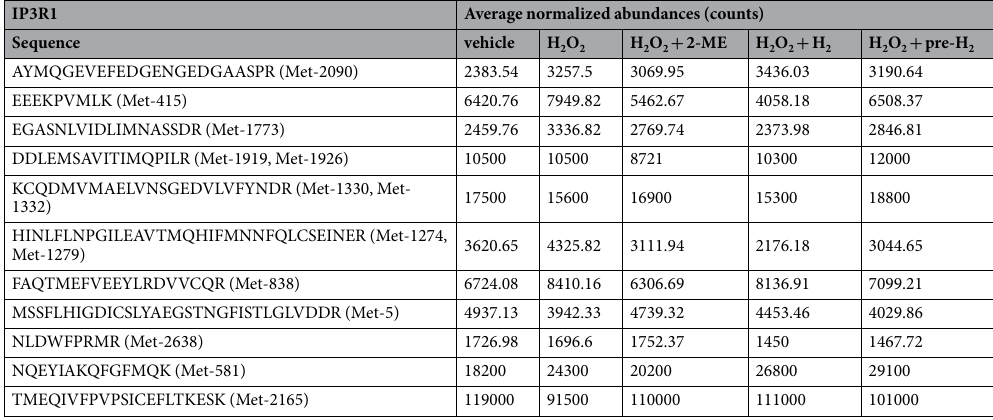
Table 1. Presentation of proteomics analysis from the methionine-labeling peptides in IP3R1. LC-MS/MS analyzed MBP-modified peptide sequences with delta mass 674.45 (Met + MBP) and isotopic quantification. Average normalized abundance reveals signal counts from each peptide with three tests. The modified Met residues are indicated by residue number in IP3R1.